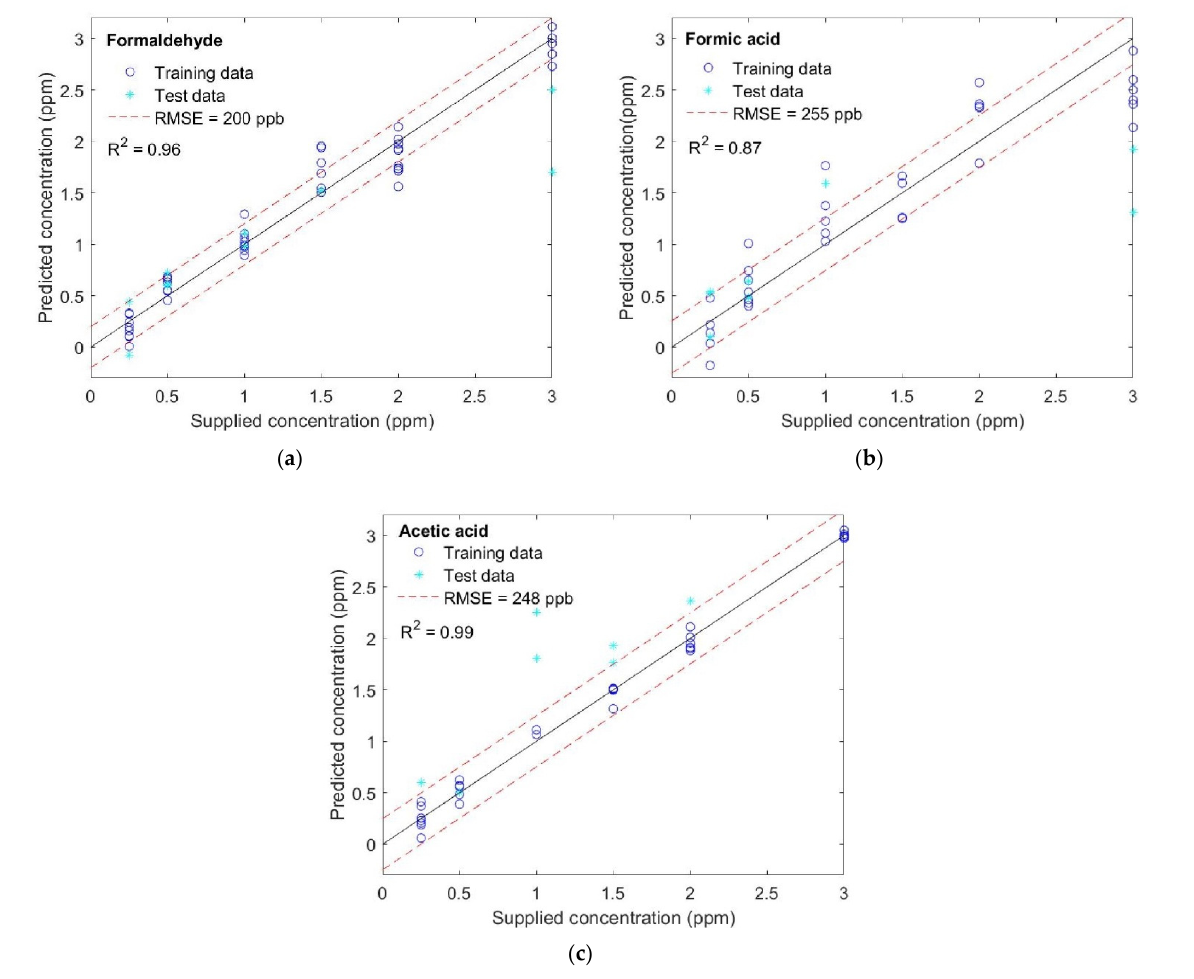
Figure 8. Results of partial least square regression for ( a ) formaldehyde, ( b ) formic acid, and ( c ) acetic acid.